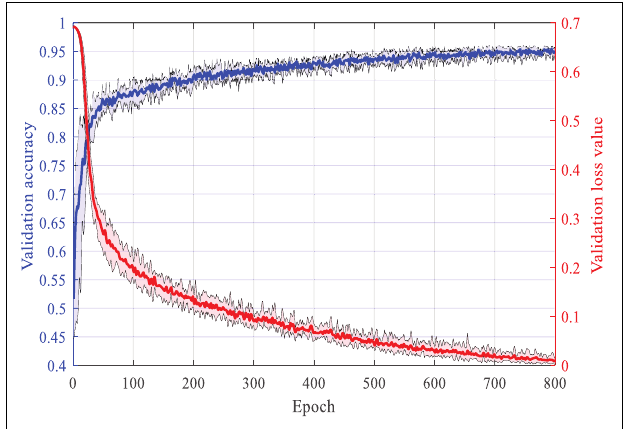
FIGURE 3 | The learning process of HDN under the supervision of the expert